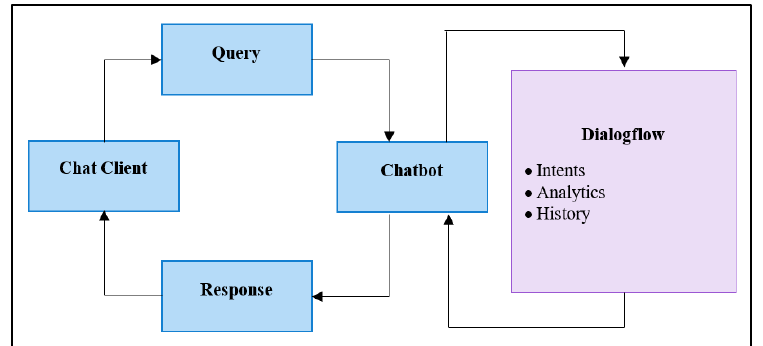
Fig. 3. Conversational chatbot architecture